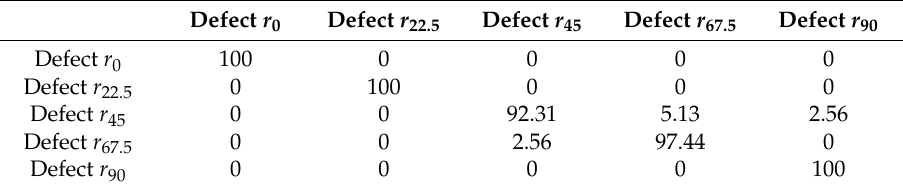
Table 6. Confusion matrix of the DCNN ROT after evaluation update procedure [%].